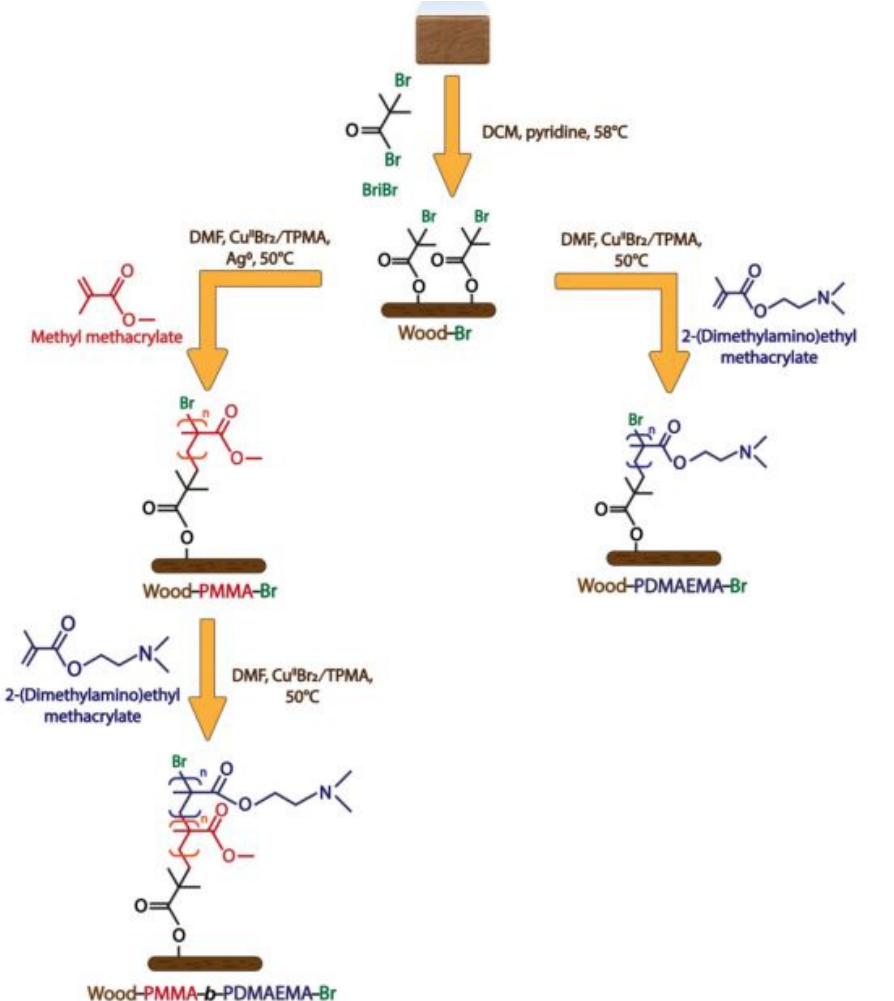
Figure 10. A two-step synthetic route for the preparation of a wood–polymer composite [97].